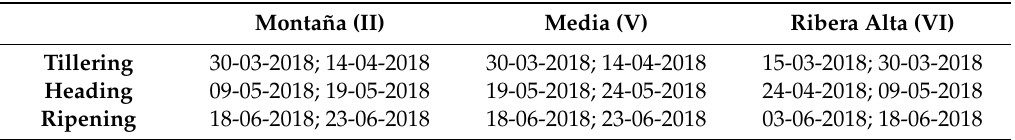
Table 3. Closest Sentinel-2 images available to the estimated phenological dates in 2018 (Table 2), used for building the prediction